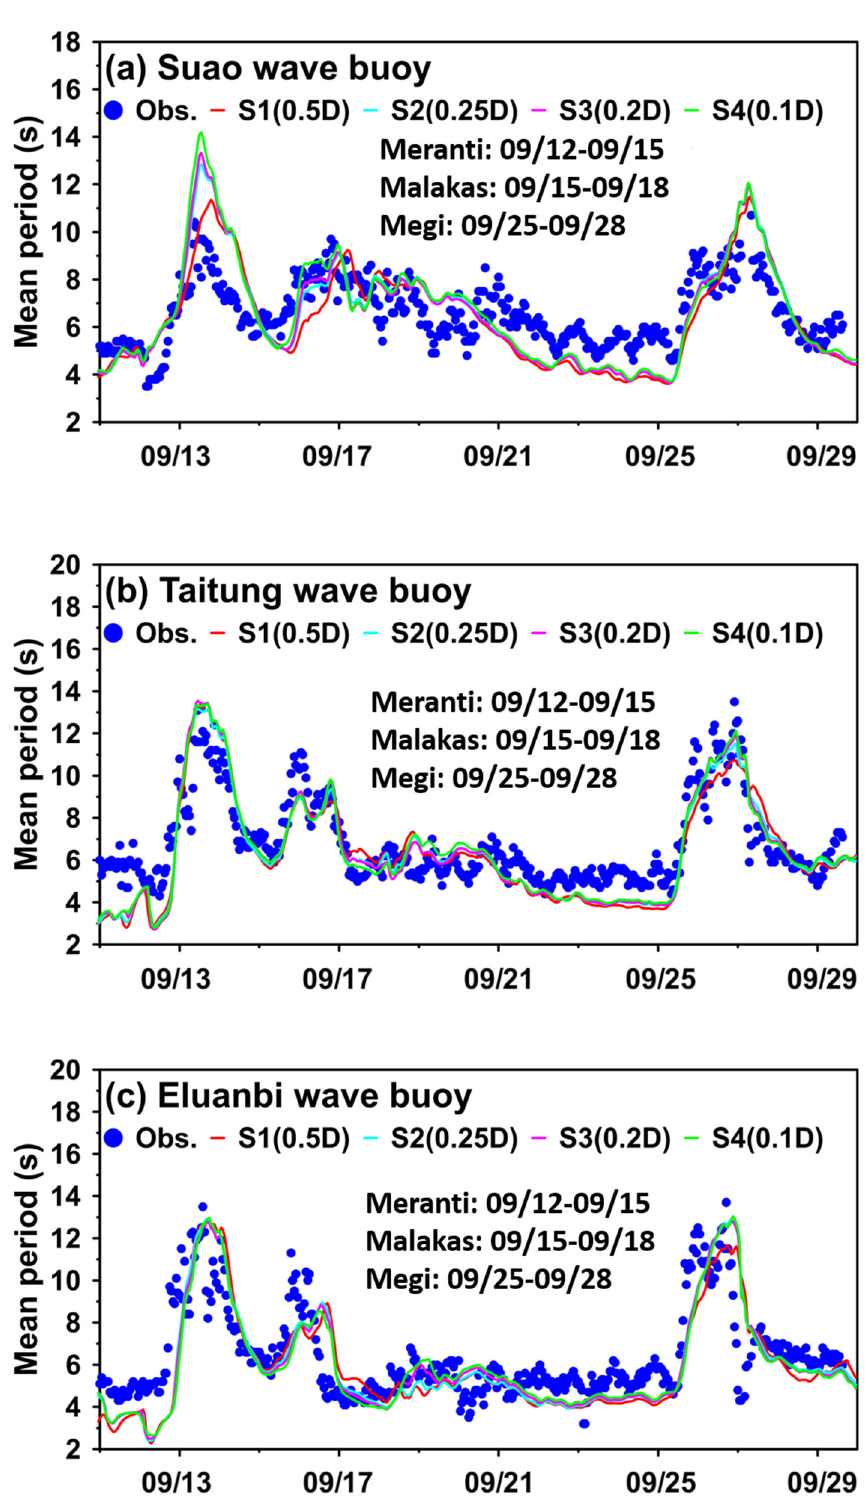
Figure 11. Comparison of the hourly mean period between simulations with different grid resolutions and measurements for the ( a ) Suao, ( b ) Taitung, and ( c ) Eluanbi wave buoys in September 2016.